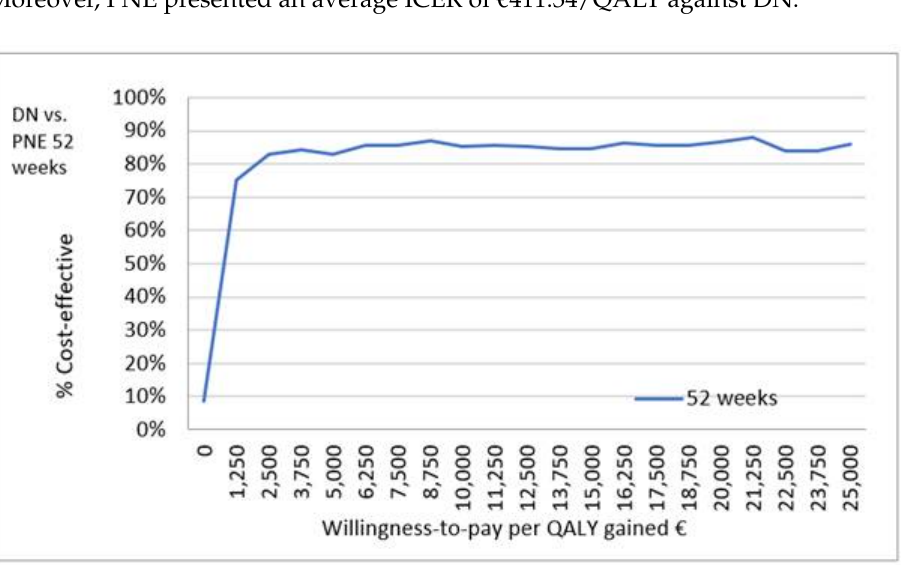
Figure 3. Cost-effectiveness acceptability curve (CEAC).